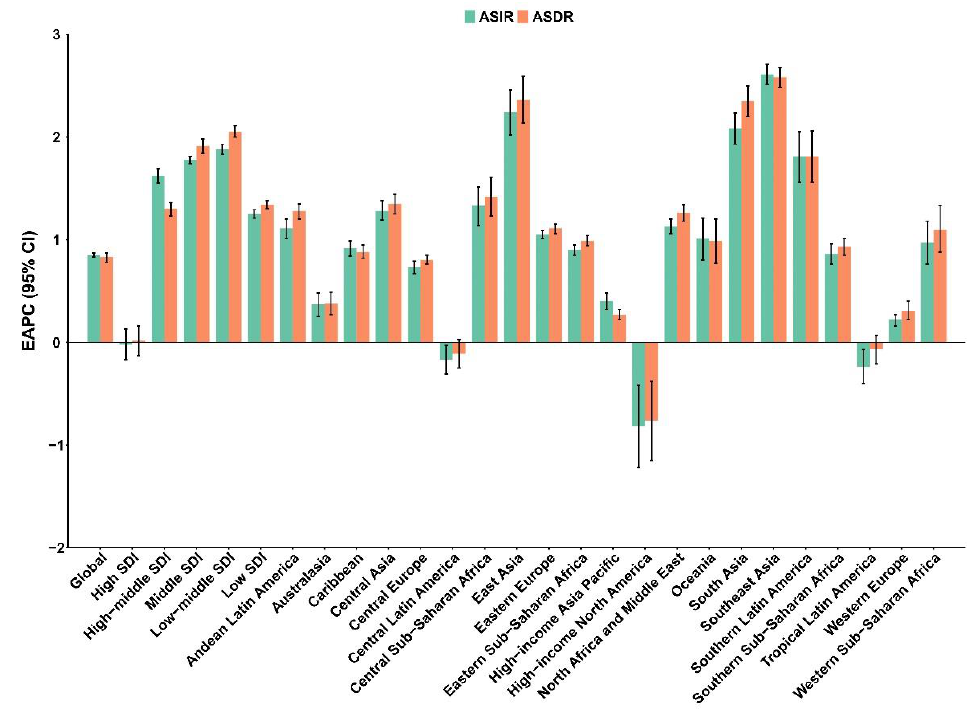
Figure 2. The EAPC for ASIR and ASDR of PCOS at the regional level. EAPC, estimated annual percentage change; ASIR, age-standardized incidence rate; ASDR, age-standardized disability-adjusted life years rate; PCOS, polycystic ovary syndrome.